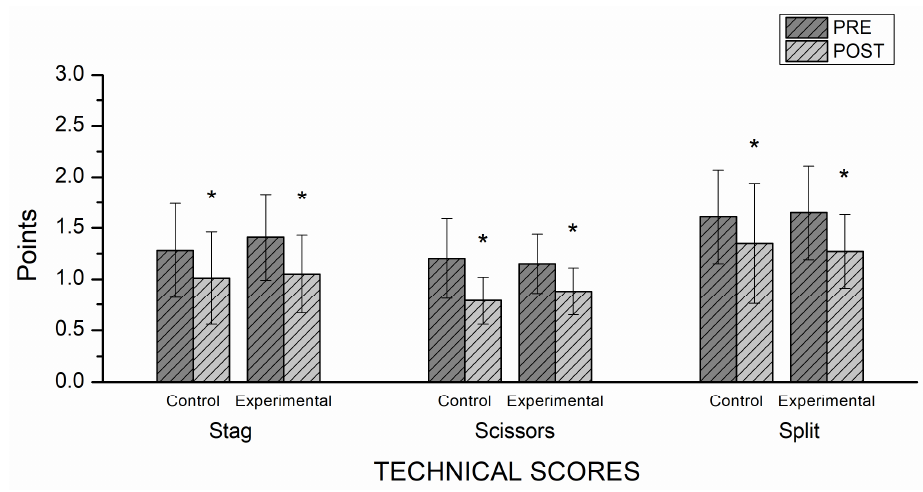
Figure 4. Judges’ technical score results. * Significant differences pre–post ( p < 0.05). Effect size results indicated a large effect on the stag and the split leap scores in the EG, as well as a medium effect on those of the CG. A large effect size is found in the scissor leap for both groups. After the CPT program, the EG recorded better results than the CG in overall RG leaps (Figure 5).